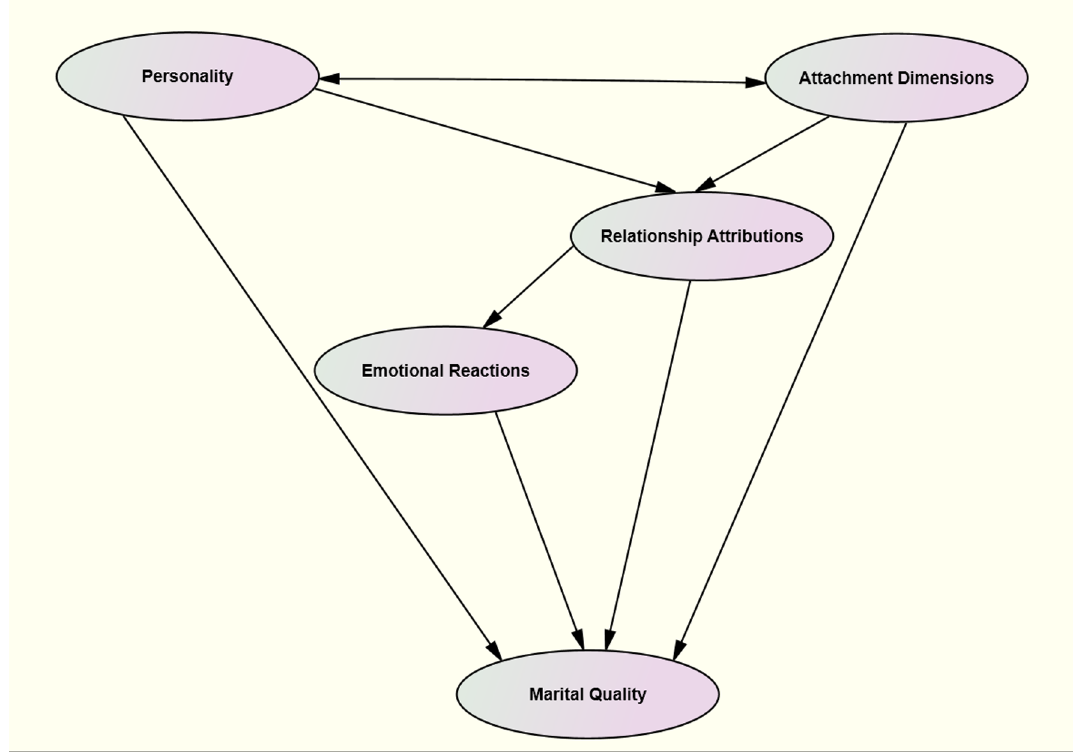
Figure 3. The intrapersonal-situational model of marital